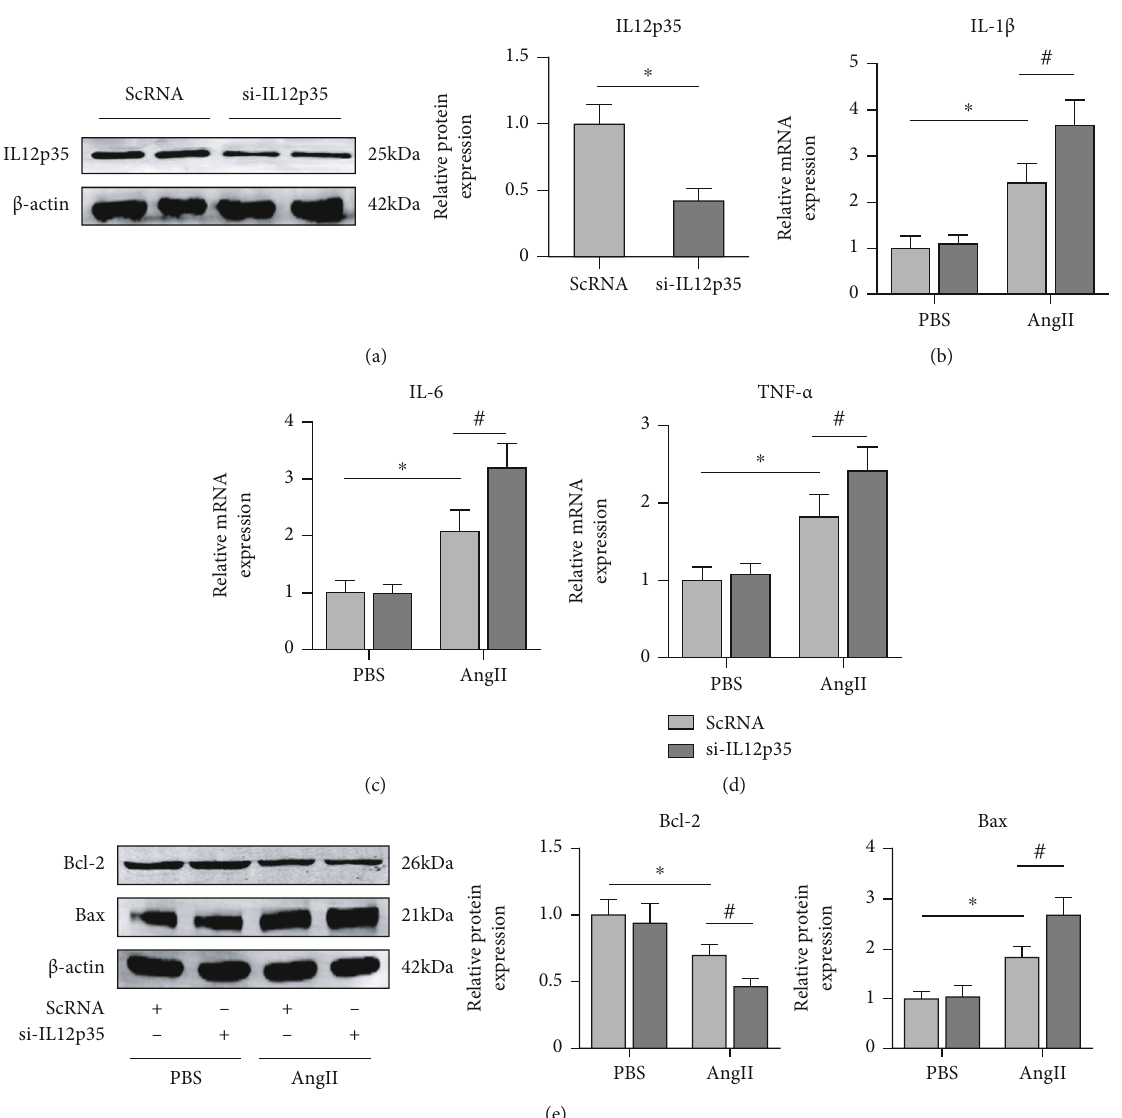
Figure 6: IL12p35 silencing exacerbates the Ang II-induced in fl ammatory response and SMC apoptosis. (a) Western blot analysis of IL12p35 expression after transfection with si-IL12p35 ( n = 5 per group). (b – d) PCR analysis of IL-1 β , IL-6, and TNF- α mRNA expression in the four groups ( n = 6 per group). (e) Western blot analysis of the protein levels of Bcl-2 and Bax in the four groups ( n = 5 per group). ∗ P < 0 : 05 compared with the PBS group; # P < 0 : 05 compared with the Ang II